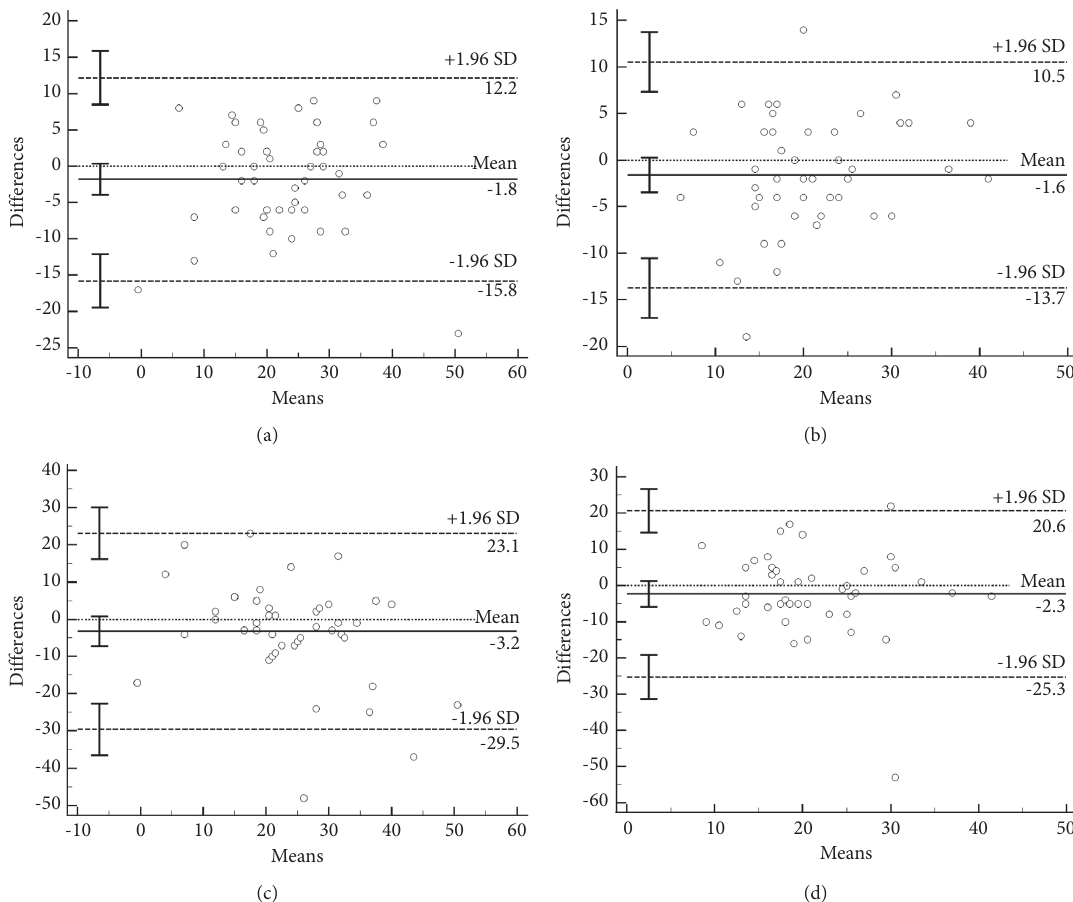
Figure 5: Comparison of the NCC and RCC overlapping between coordinates generated using each method on (a) horizontal and (b) vertical axes and comparison of the optimal projection to visualize the LMCA ostium between coordinates generated by each method on (c) horizontal and (d) vertical axes.